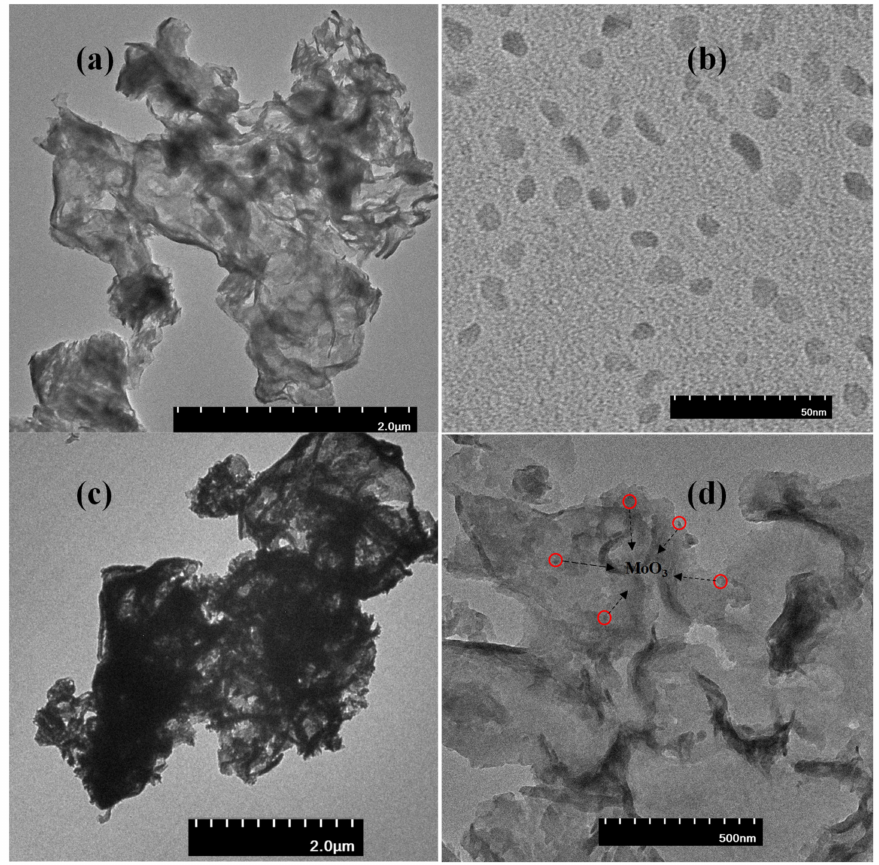
Figure 2. Microscopic image of ( a ) g-C 3 N 4 , ( b ) MoO 3 and ( c , d ) g-C 3 N 4 /MoO 3 (3%)